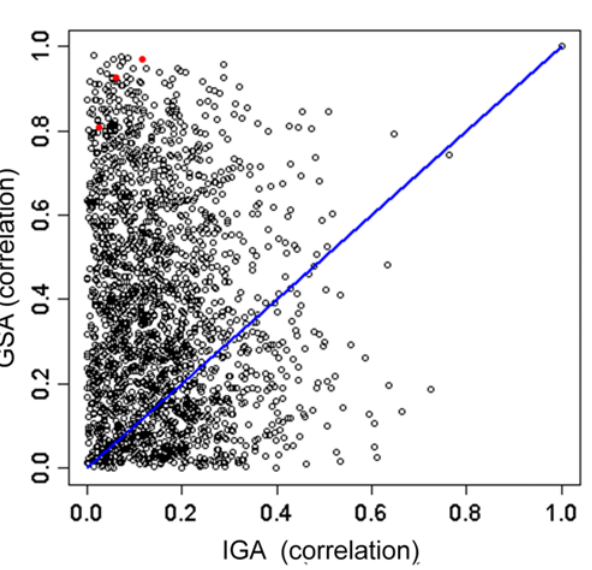
Fig 5. Same-target drug-pairs correlate better when evaluated by gene-set/tag enrichment scores. Figure plots correlation of same-target drug pair evaluated by tag enrichment score (ES) versus that evaluated by gene expression. Drug targets were those given by TTD database. In the tag approach, each drug, or CMap perturbagen, was represented by the ESs of 4884 MSigDB tags. In the gene expression case, each drug was represented by the set of top-4884 high variance genes. The three red dots are from the three pairs formed by the three drugs, vorinostat, valproic acid, and trichostatin A, all targeting the histone deacetylase (HDAC) protein.